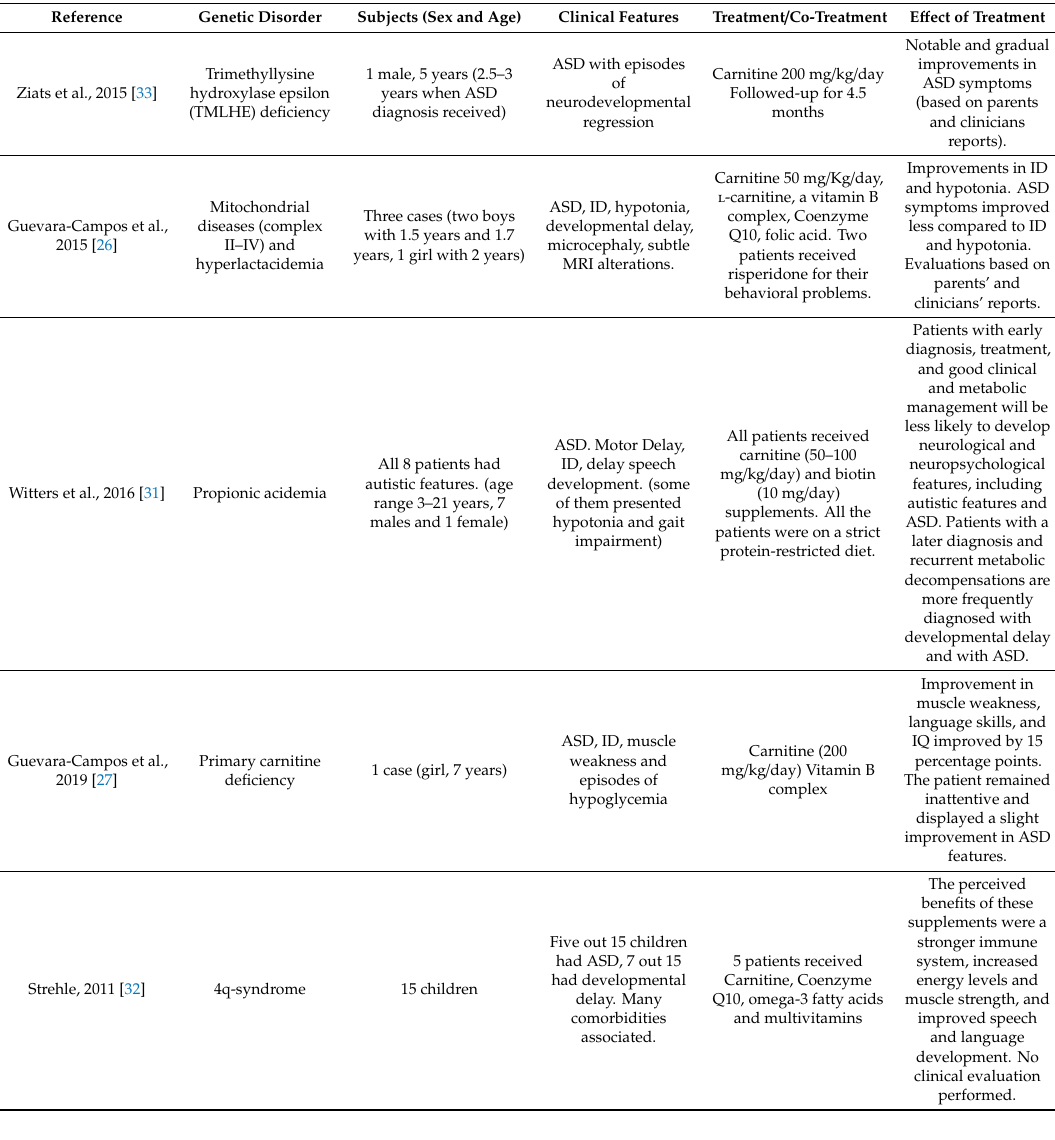
Table 2. E ff ects of carnitine treatment on ASD associated with genetic